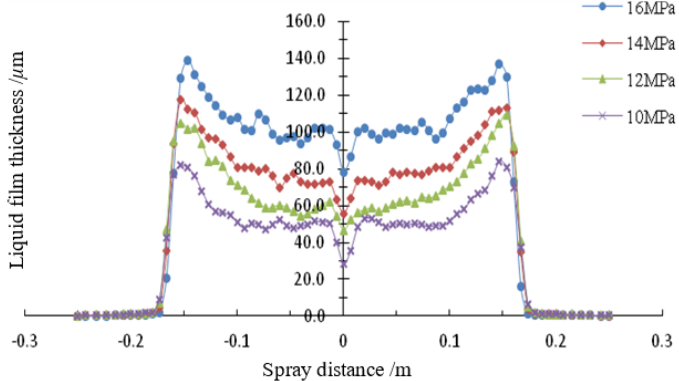
Figure 26. Variation curve of liquid film thickness with distance from the axis.